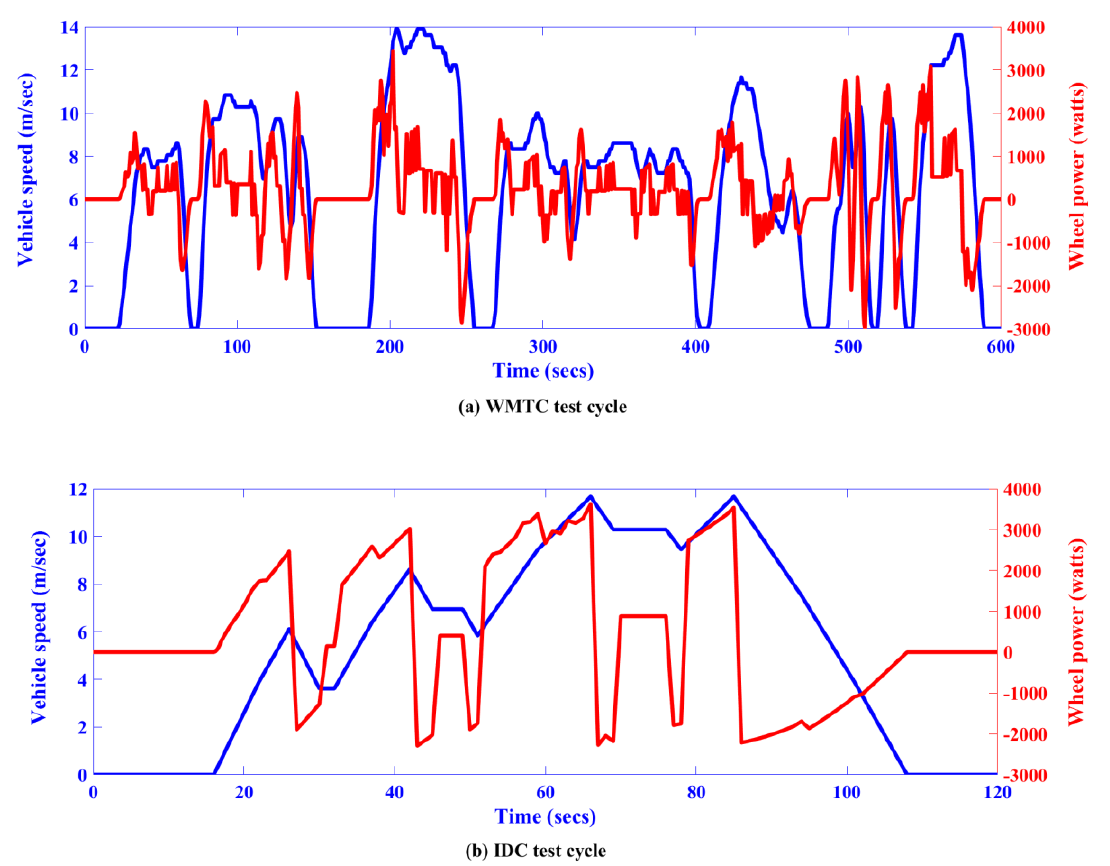
Figure 4. Vehicle speed and wheel power for ( a ) Worldwide Motorcycle Test Cycle (WMTC) and ( b ) Indian Drive Cycle (IDC).